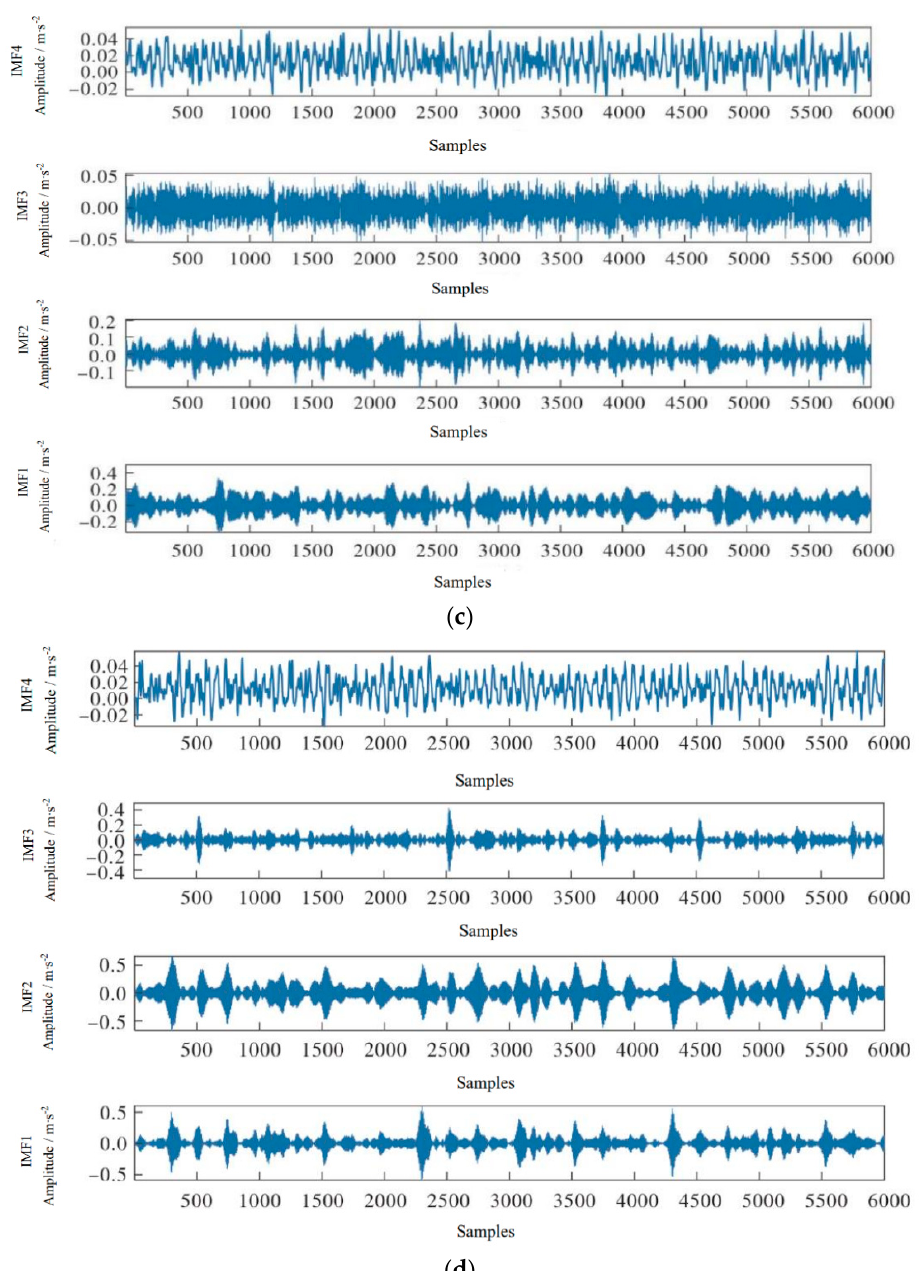
Figure 8. VMD decomposition results of four states. ( a ) Normal. ( b ) Inner ring fault. ( c ) Rolling body fault. ( d ) Outer ring fault.